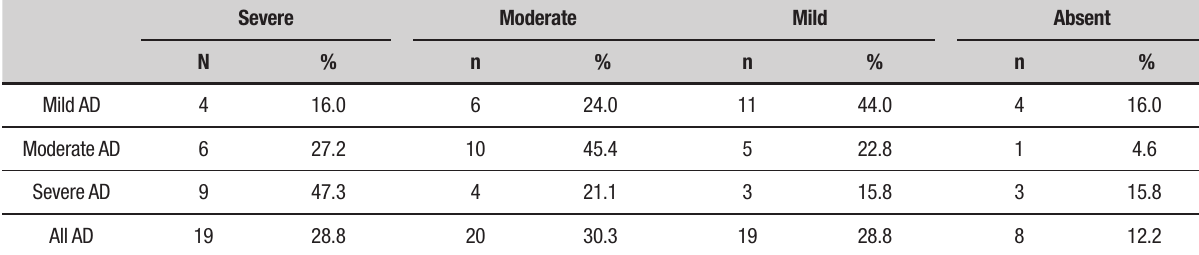
Table 2. Distribution of burden levels of family caregivers according to ZBS. 6 São Carlos, SP, Brazil. 2015.